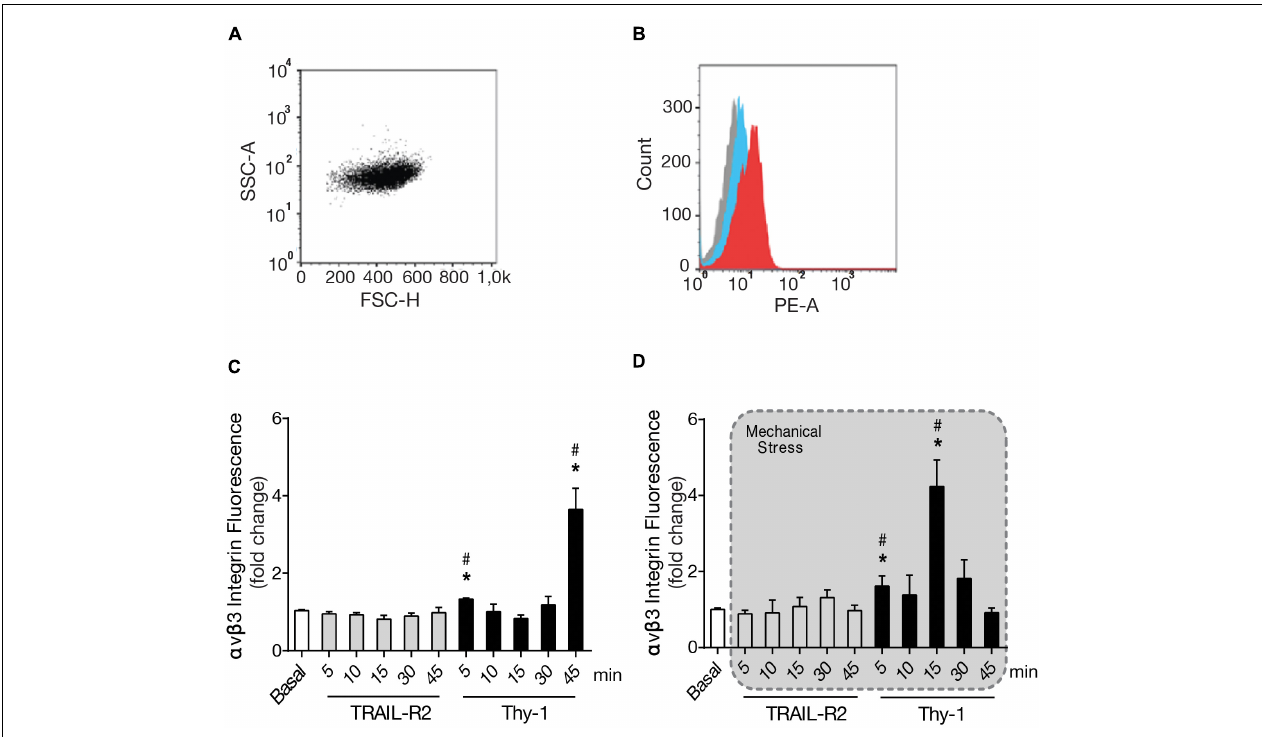
FIGURE 5 | Thy-1 plus mechanical stress increase surface levels of α V β 3 Integrin faster than Thy-1 alone. (A) Forward and side scattering (FSC-H and SSC-A) gating shows the selected cell population, based on size and granularity. (B) The three cell populations shown correspond to non-labeled control (gray), isotype control (cyan) and α V β 3 Integrin/Phycoerythrin (red). (C,D) DITNC cells were incubated with serum-free medium for 30 min and stimulated with Protein A-magnetic beads coated with Thy-1, with and without mechanical forces exerted with a magnet for 5, 10, 15, 30, and 45 min. Values in the graph are the mean fluorescence intensities normalized to the control signal (basal), TRAIL-R2 is a negative control in experiments with Thy-1. Values in the graph are the mean fluorescence intensities of α V β 3 Integrin/Phycoerythrin, normalized to basal levels without stimuli. Values in the graphs represent mean + s.e.m. ( n = 3). Statistical significance was calculated using Kruskal–Wallis non-parametric test, with Dunn’s multiple comparison. * and #, p < 0,05. * compared to the basal condition, # compared to TRAIL-R2 incubated for the same